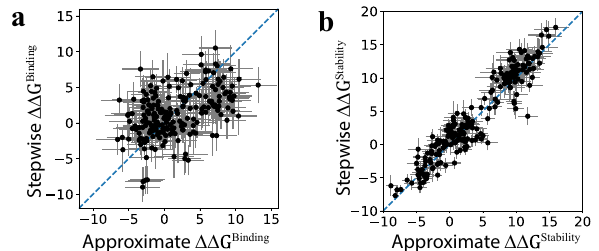
Figure 6. Comparisons of the (cid:31)(cid:31) G values for 221 multi-point mutants obtained from two methods, as described in the text. The approximate (cid:31)(cid:31) G for the mutant is the sum of the (cid:31)(cid:31) G values for the corresponding single mutations with respect to the wildtype. The stepwise (cid:31)(cid:31) G for the mutant is calculated by adding the incremental (cid:31)(cid:31) G values when the wildtype is transformed to the mutant one residue at a time. The (cid:31)(cid:31) G is shown for both the binding to the SARS-CoV-2 RBD ( a ) and the stability of the mutant ( b ). All the units are in